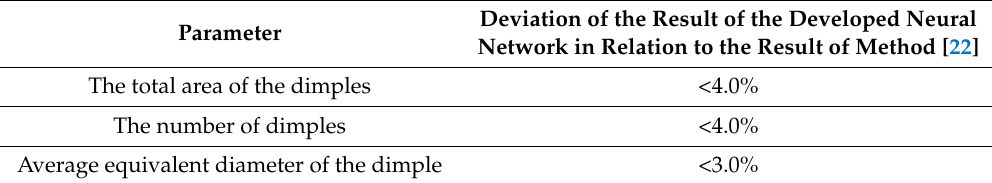
Table 2. Comparison of the results obtained using the neural network and method [22].